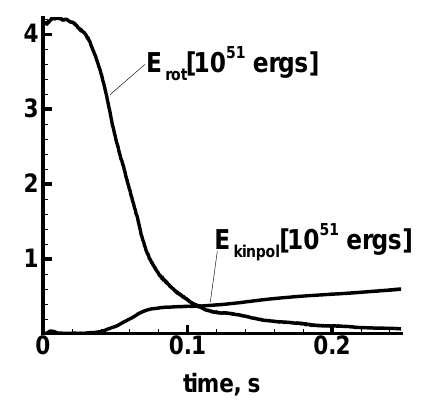
Figure 3: Time dependence of rotational, kinetic poloidal, and magnetic energies during explosion for a dipole -like field, from [22].